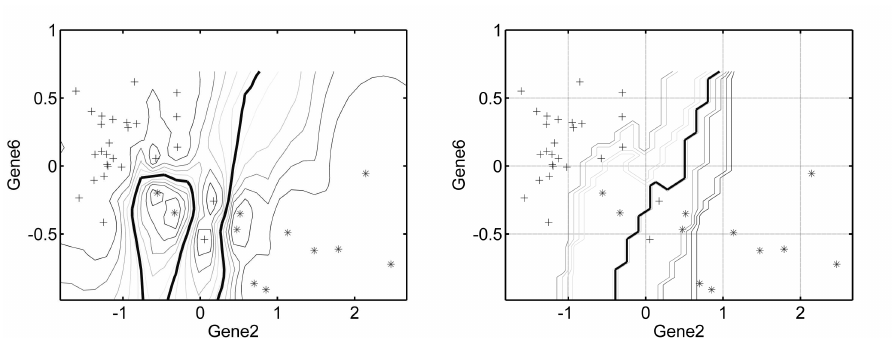
Figure 9. Nearest neighbor classifiers 1NN (apparent error = 0.105, CV = 0.06, SD = 0.03) and 5 kNN (apparent error = 0.105, CV = 0.105, (SD <